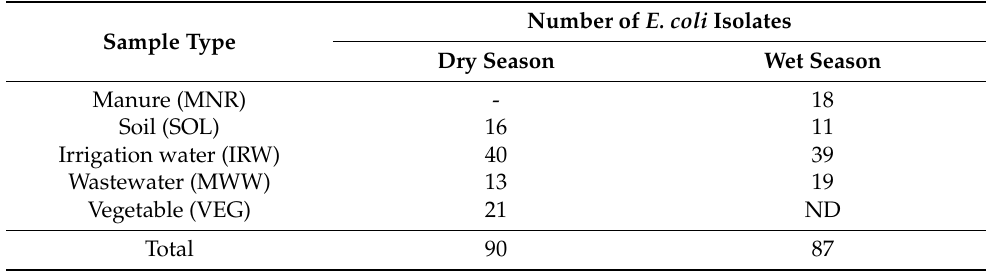
Table 2. Number of E. coli isolates for samples collected during the dry and wet season in 2018. Sample